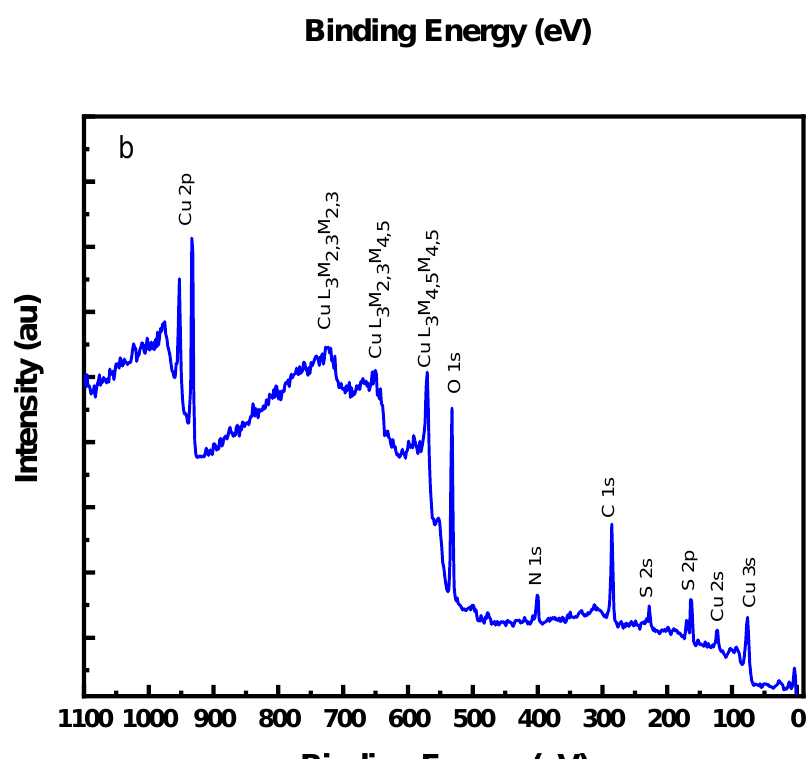
Figure 10. Survey spectrum of ( a ) sputter cleaned brass sample and of ( b ) 0.25 mM P2T inhibitor treated brass sample in 0.5 M H 2 SO 4 for 6 h.